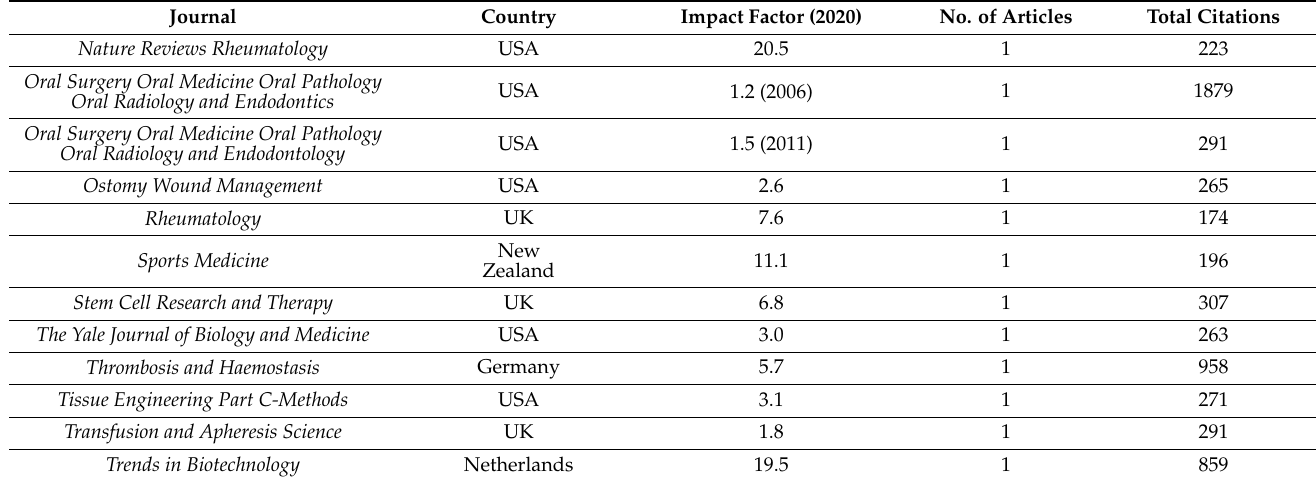
The top-cited articles were focused on seven disciplines: Musculoskeletal system/Orthopedics (n = 54), Dentistry/Maxillofacial surgery (n = 17), Biology (n = 8), Manufacturing (n = 6), Cosmetic/Plastic surgery (n = 6), Multiple (n = 5), and Dermatology (n = 4) (Figure 5).